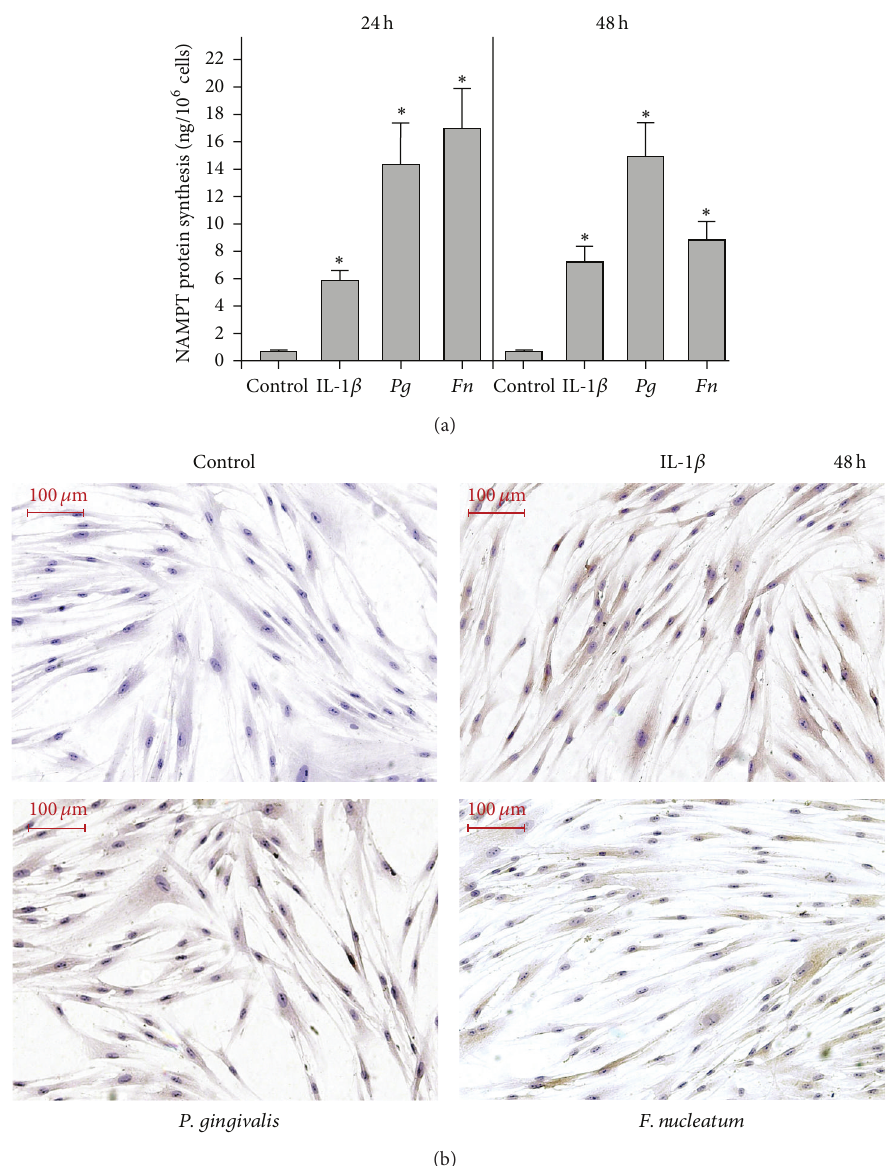
Figure 2: NAMPT protein levels in HGF. (a) NAMPT protein levels in supernatants of IL-1 𝛽 -, P. gingivalis- ( Pg- ), and F. nucleatum- ( Fn- ) stimulated HGF from 3 donors at 24 h and 48h. Mean ± SEM; ∗ significantly ( 𝑃 < 0.05 ) different from control. (b) NAMPT protein in HGF in the presence and absence of IL-1 𝛽 , P. gingivalis, and F. nucleatum at 48 h, as analyzed by immunocytochemistry. Images from one representative donor are